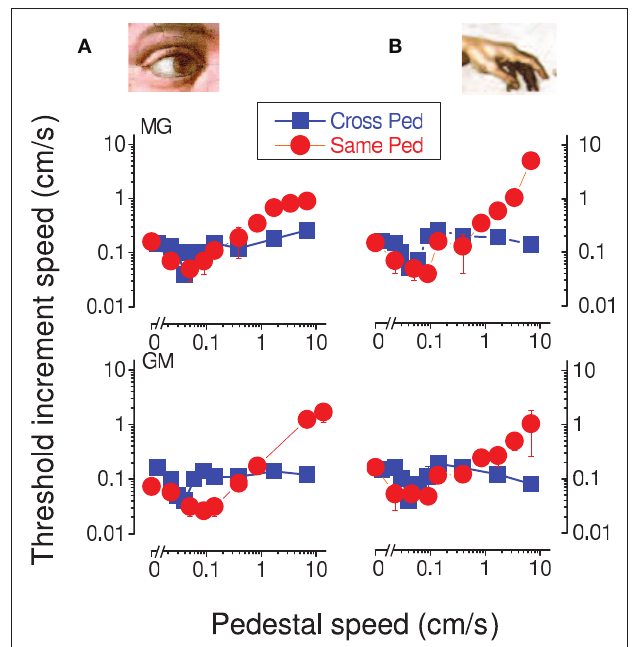
Figure 5 | incremental speed thresholds for the facilitation between senses condition incremental speed thresholds for visual (A) and tactile (B) motion, as a function of base speed, for two observers. Red circular symbols show unimodal thresholds, where all signals are confined to the same modality, vision (A) or touch (B) . The blue symbols show thresholds for pedestals of different modality to the test, tactile (B) or visual